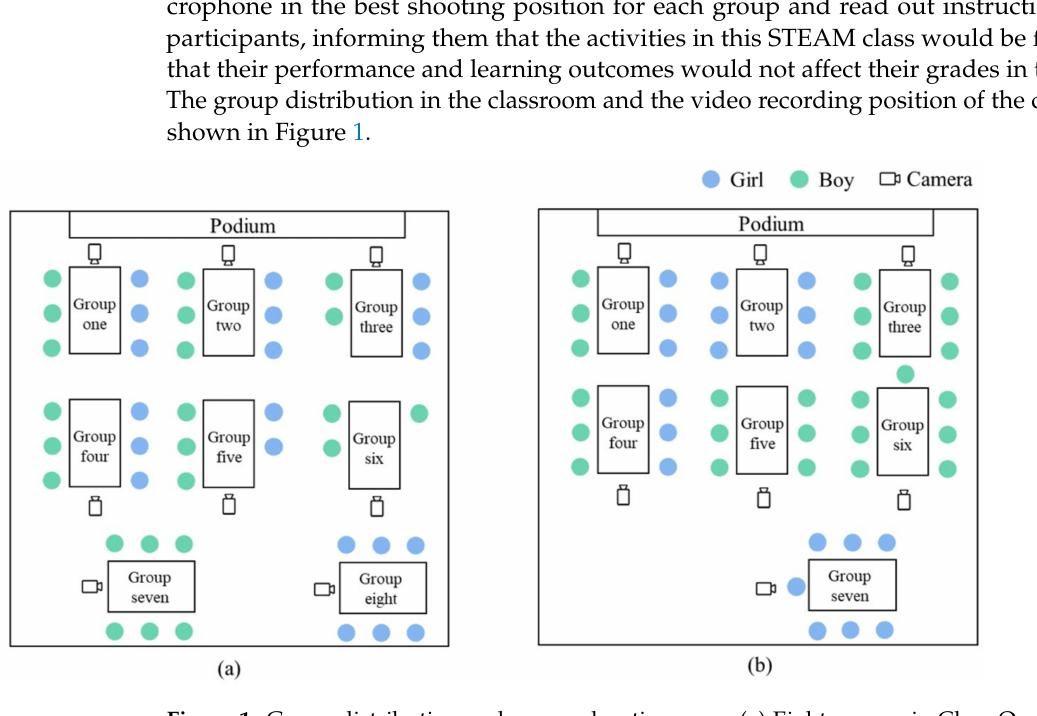
Figure 1. Group distribution and camera location map. ( a ) Eight groups in Class One; ( b ) Seven groups in Class